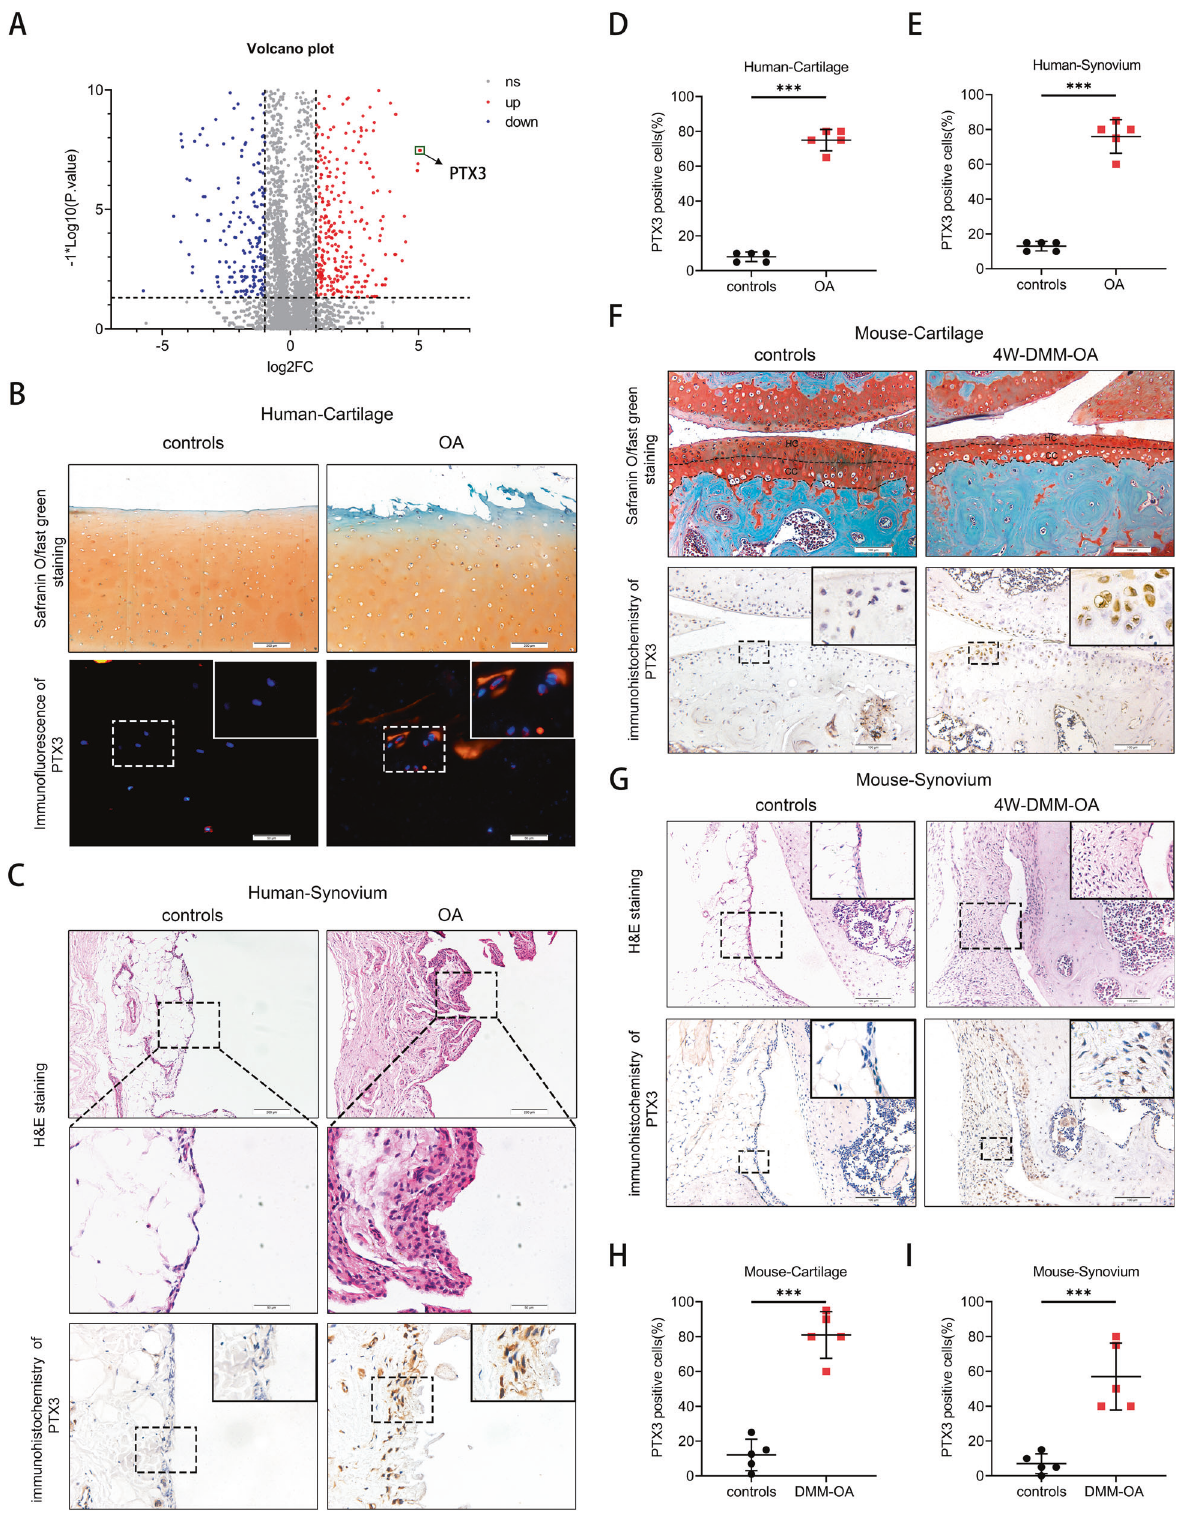
as was the expression of the pro-in fl ammatory cytokines IL-1 β , IL- 6, and TNF- α (Fig. 5E, F and Supplementary Fig. 5C). In contrast, inhibition of another PTX3-related receptor, P-selectin